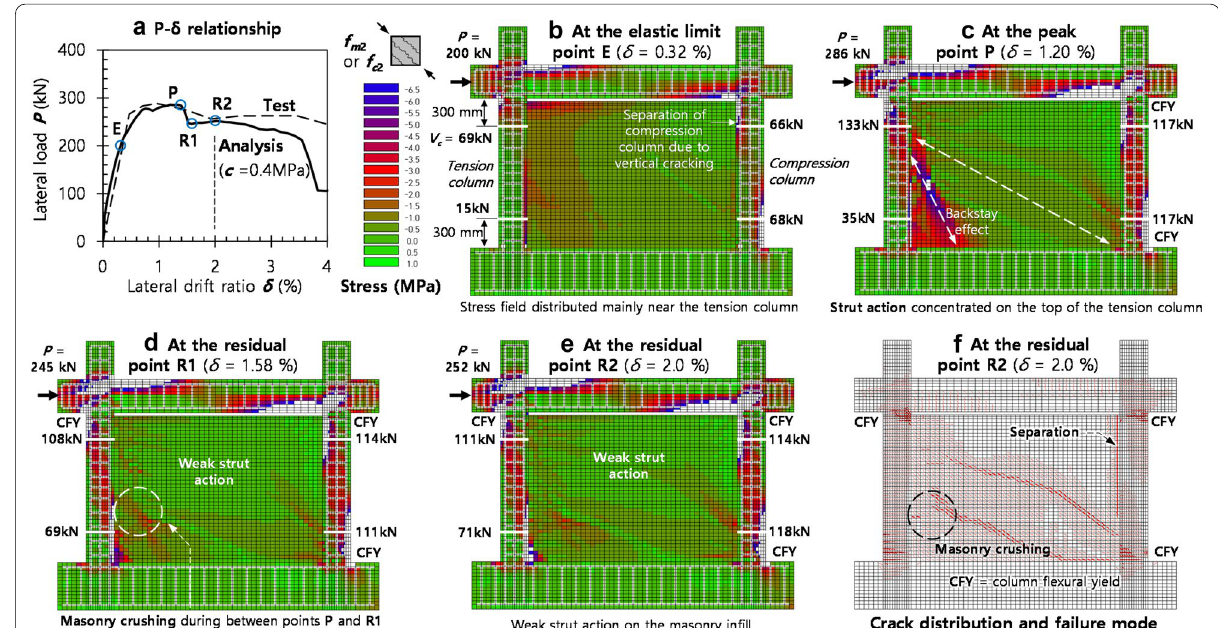
Fig. 8 Variation of stress distribution and force transfer with deformation: substandard infilled frame IFS0.5–weak masonry infill.